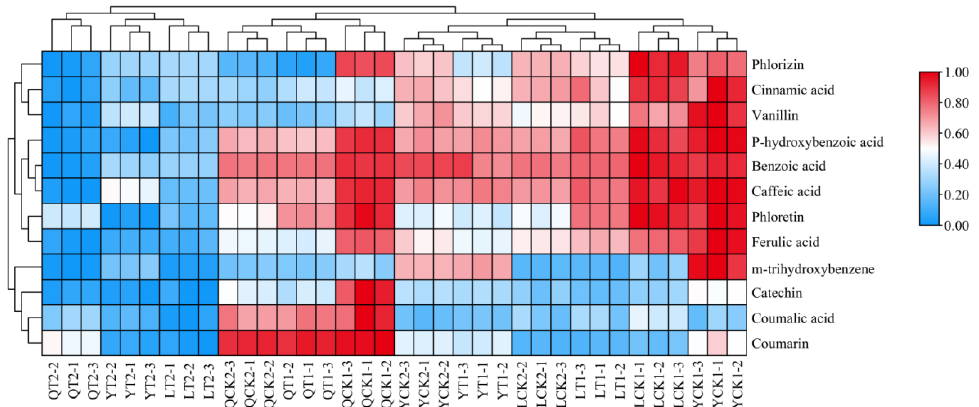
Figure 2. Effects of different treatments on soil phenolic acids in three places. LCK1: replant control in Laizhou, LCK2: methyl bromide fumigation in Laizhou, LT1: blank carrier treatment in Laizhou,